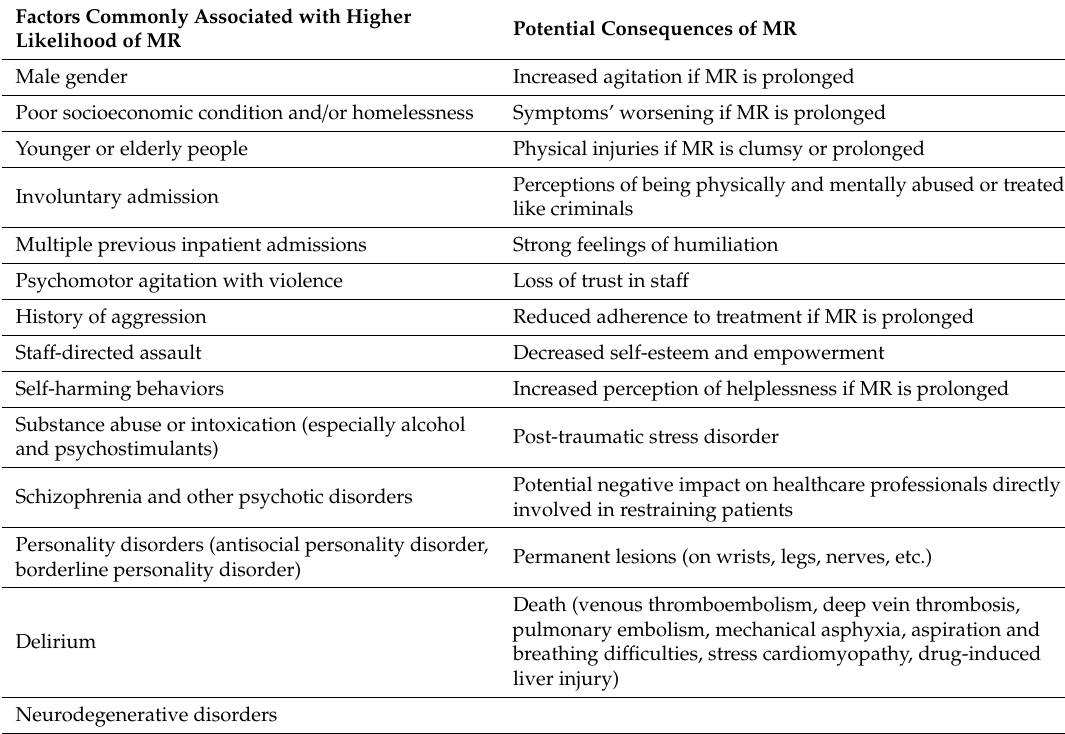
Table 1. Factors and potential consequences associated with mechanical restraint (MR) in patients with psychiatric and neurological